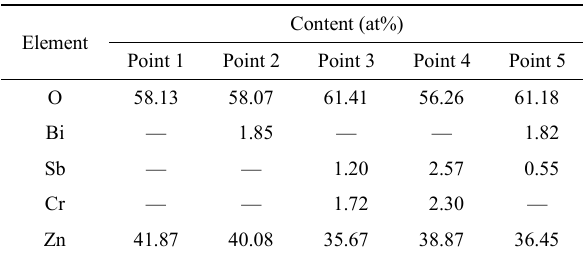
Table 3 Results of EDS analysis in the points